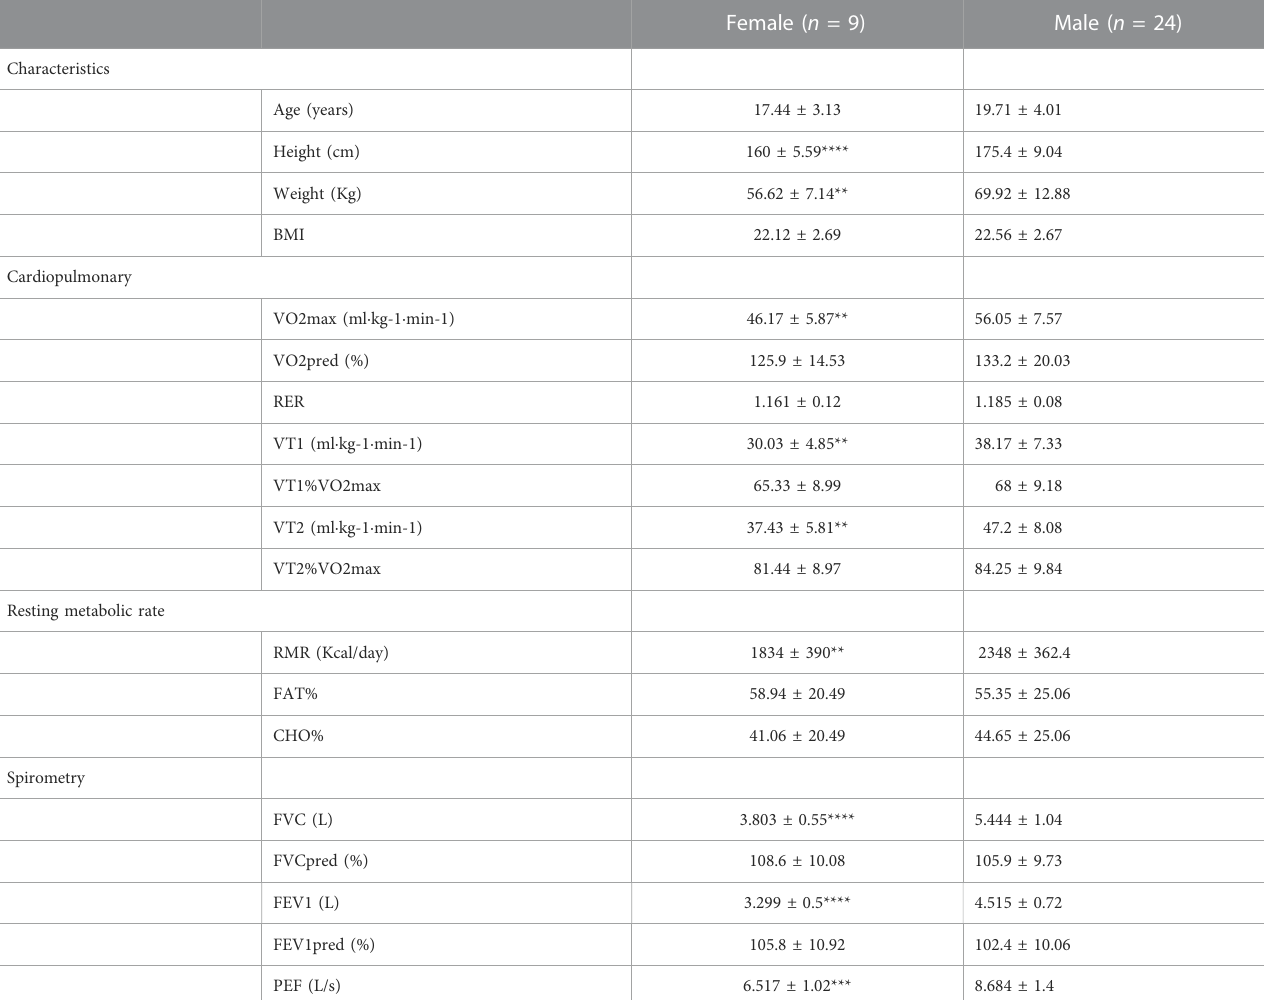
TABLE 1 Demographics, cardiopulmonary, resting metabolic rate, and pulmonary function.